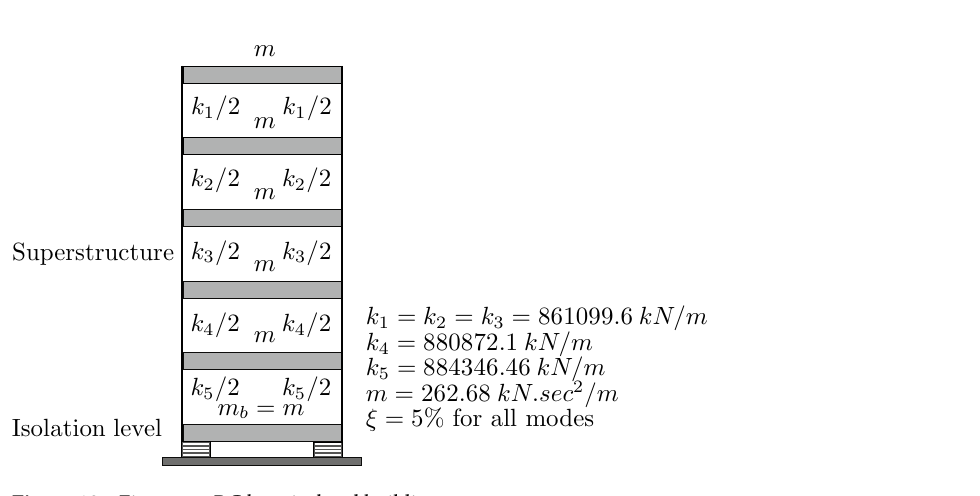
Figure 10. Five-story RC base isolated